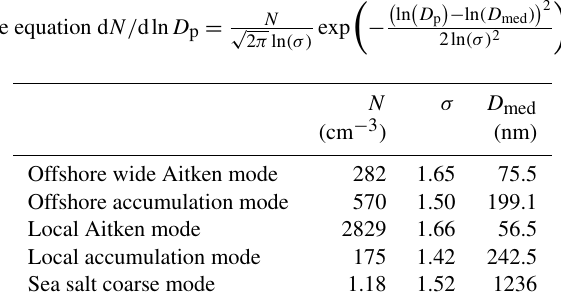
Table 2. Lognormal fit parameters for the fits shown in Fig. 8, using the equation d N/ dln D p